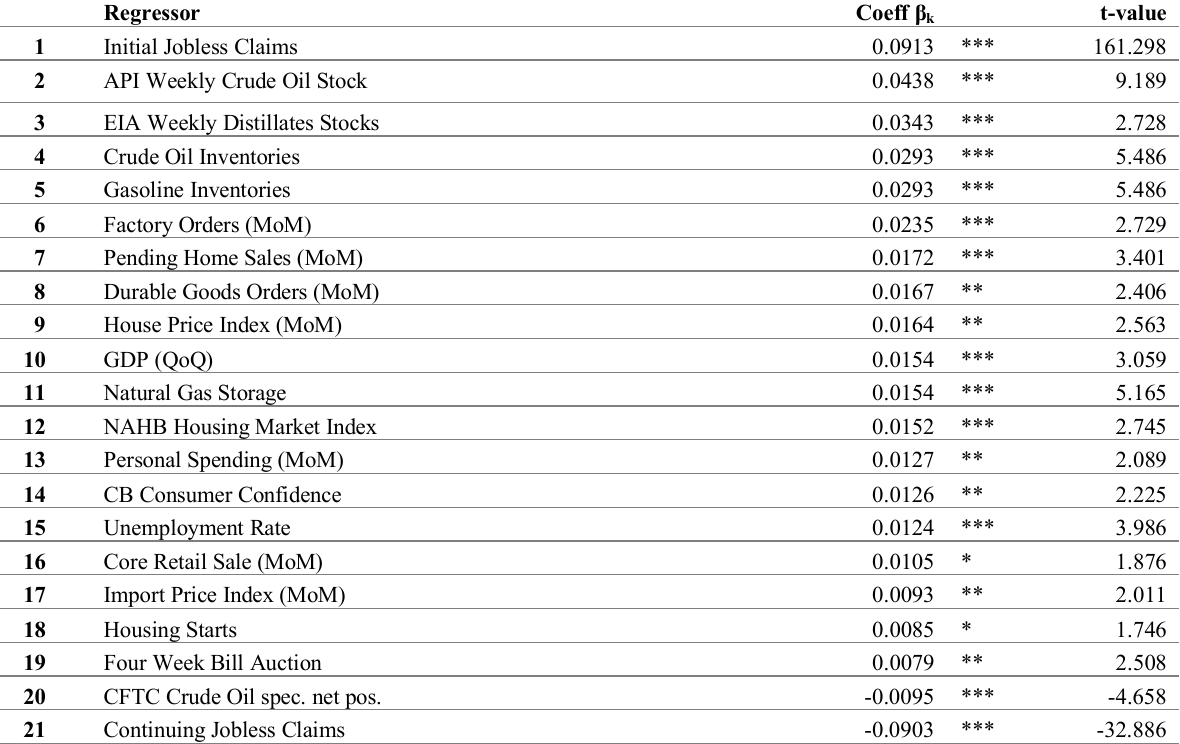
Table 5: Ranking of Significant US News Announcements on WTI Crude Oil; Multiple Auto- regressive